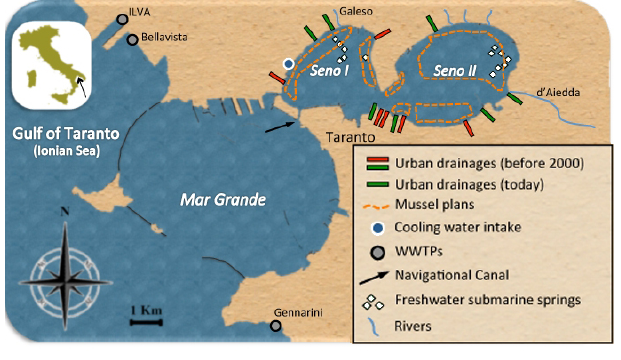
Fig. 1 . Map of the Taranto Sea system (northern Ionian, Mediterranean Sea) including the two sub-basins of Mar Piccolo, Mar Grande, and the nearby Ionian Sea (Gulf of Taranto). Note that the Bellavista and Gennarini wastewater treatment plants (WWTPs) closed in the period 2000-2006 whereas ILVA is mainly an industrial discharge. The simulation period of the model concerns the distribution and extension of the mussel farms in Mar Piccolo during 2002-2004. In sub-basin Seno I mussel farms covered 26% of the total area of 8.3 km² whereas in sub-basin Seno II they covered 66% of the total area of 12.4 km².